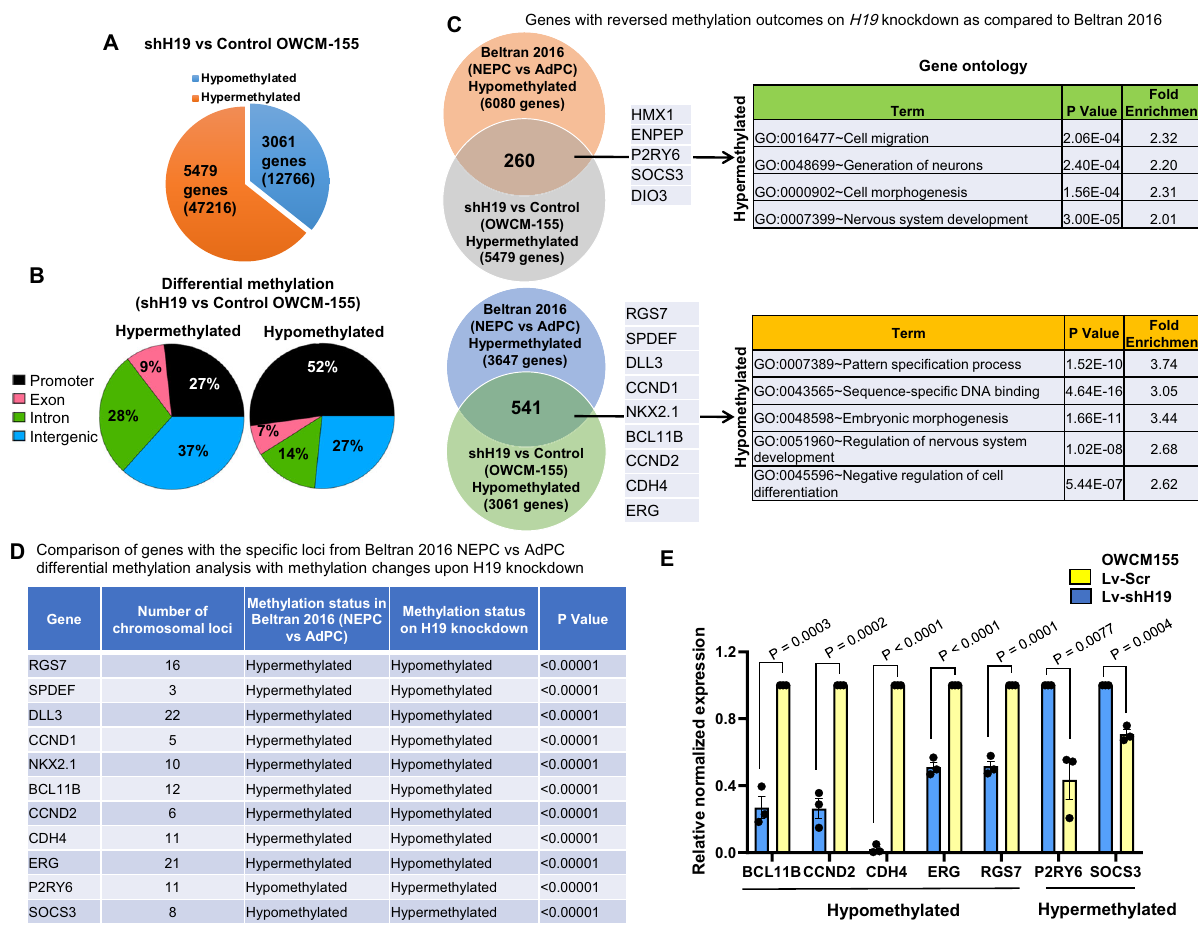
Fig. 8 Genome-wide methylation analysis of H19 knockdown in NEPC organoid. A Pie chart showing the number of differentially methylated genes (shH19 vs. control OWCM-155, n = 3 biologically independent replicates), identi fi ed by annotating hyper- and hypomethylated loci (the number is reported in parentheses) (p-adj. < 0.01). B Pie chart depicting the percent DNA methylation-based on indicated gene regions. C Left, Venn diagram of comparison of shH19 vs. control OWCM-155 differential methylation gene set vs. the Beltran 2016 differential methylation gene set, NEPC vs. AdPC. The common area depicts the number of genes with reversal of methylation outcomes. Middle, example lists selected genes with reversed methylation upon H19 knockdown. Right, selection of functional categories enriched after analysis of differentially methylated genes ( p -value < 0.001). D Number of chromosomal loci of selected genes with reversed methylation outcomes upon H19 knockdown ( p value < 0.005). See Methods for statistical determinations ( A – D ). E Gene expression analysis of differentially methylated genes in OWCM-155 NEPC organoid with shH19 (Lv-shH19) compared to control (Lv-Scr). Data are mean ± SEM ( E ); n = 3 biological replicates. p Values were calculated by unpaired two-tailed Student t test ( E signi fi cantly higher probability of BCR or MET (Fig. 9C — p - value = 0.00996 and p -value = 0.0162, respectively). With H19 expression strati fi ed in the same manner, we also generated Kaplan – Meier curves in untreated patients. Unlike ADT-treated patients, untreated patients did not signi fi cantly differ in the probability for BCR nor MET (Fig. 9B — p -value = 0.627 and p - value = 0.880, respectively). Taken together, in patients that receive ADT and consequently have a higher probability of